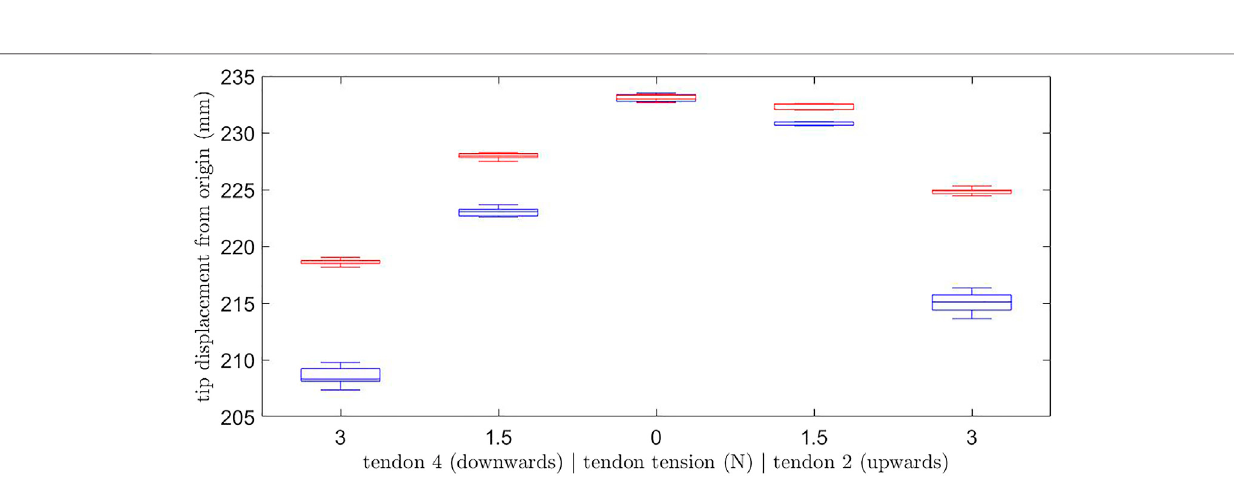
Frontiers in Robotics and AI |